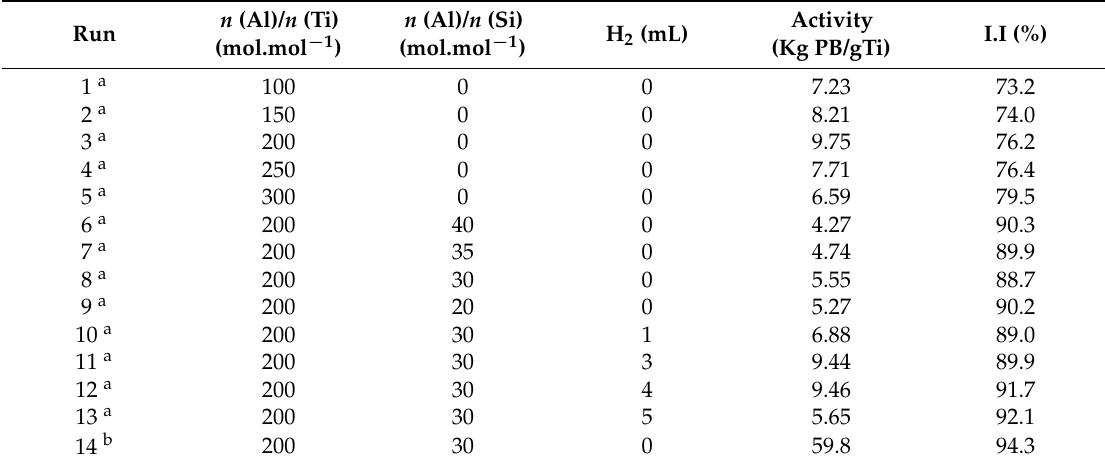
Table 3. The effect of the Al/Ti, Al/Si molar ratios and H 2 on the Cat-3 in 1-butene slurry